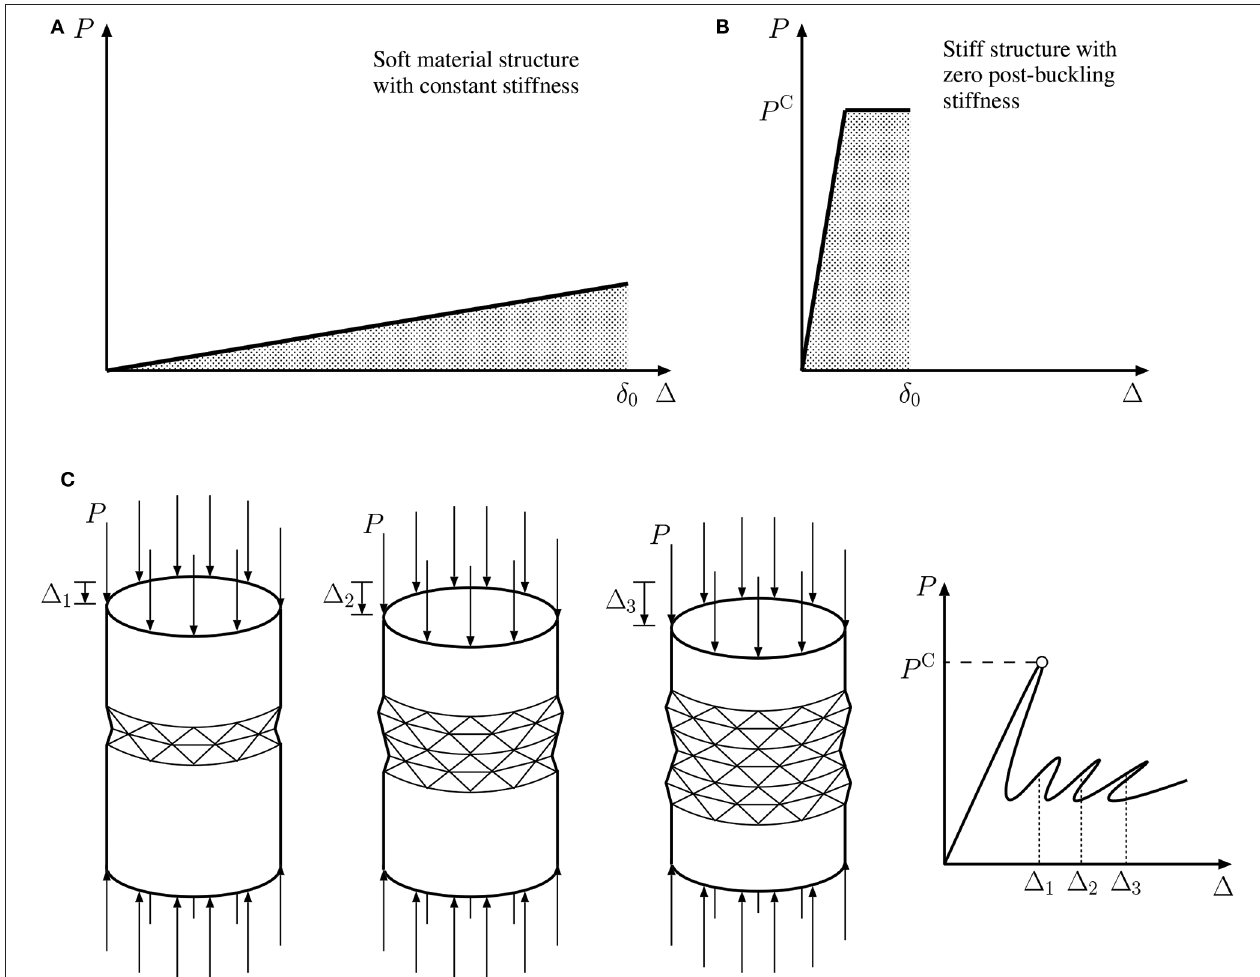
FIGURE 1 | (A,B) Example mechanical responses showing load P vs. deflection 1 relationships with equal-sized shaded areas and δ 0 marking the corresponding deflection representing strain energy absorbed for structures made from: (A) a soft linear elastic material; (B) a structure made from a stiffer material with a critical buckling load P C and a zero stiffness post-buckling response. (C) Sequential cellular buckling response of an elastic axially compressed cylindrical shell (Hunt et al.,